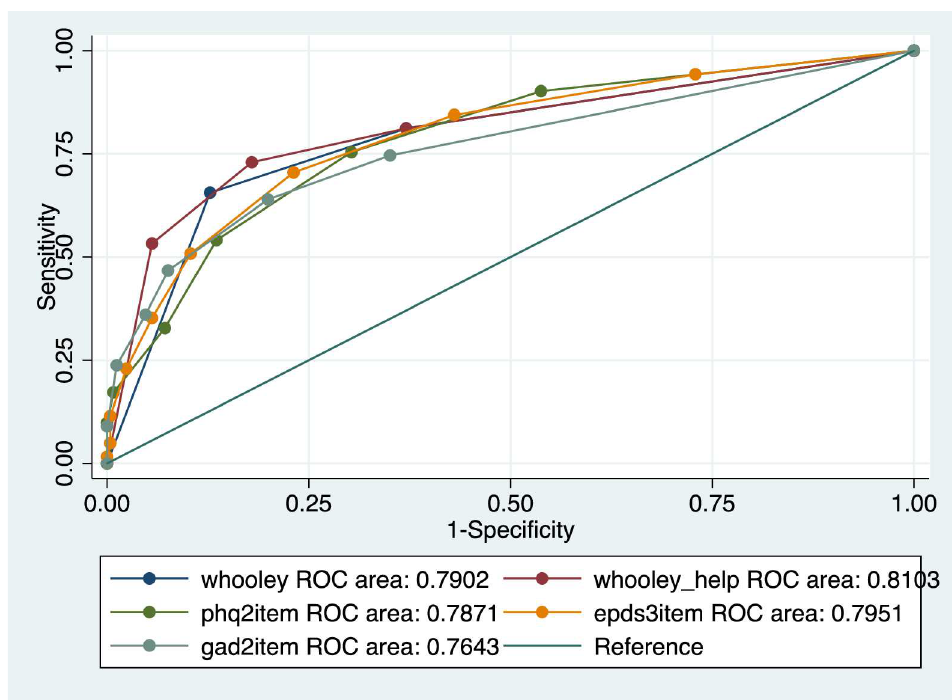
Fig 2. Roc comparison of performance of ultra-brief screening tools for detecting MDE and/or anxiety disorders.